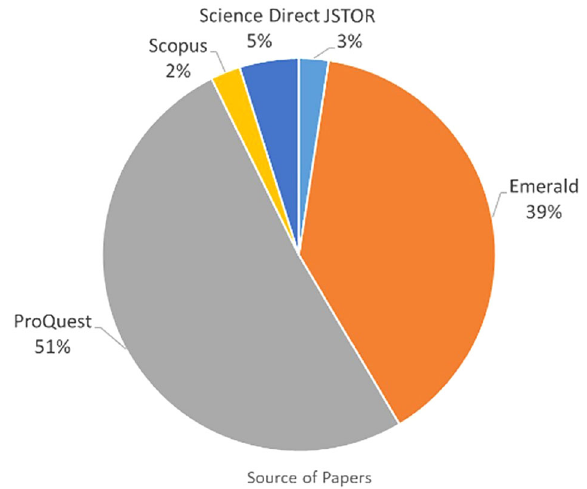
Figure 4. Percentage of 41 papers by source